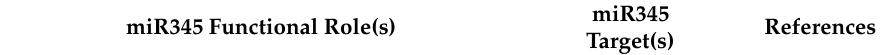
Table 1. Denotes the role of MiRNA-345 in different cancers. Section